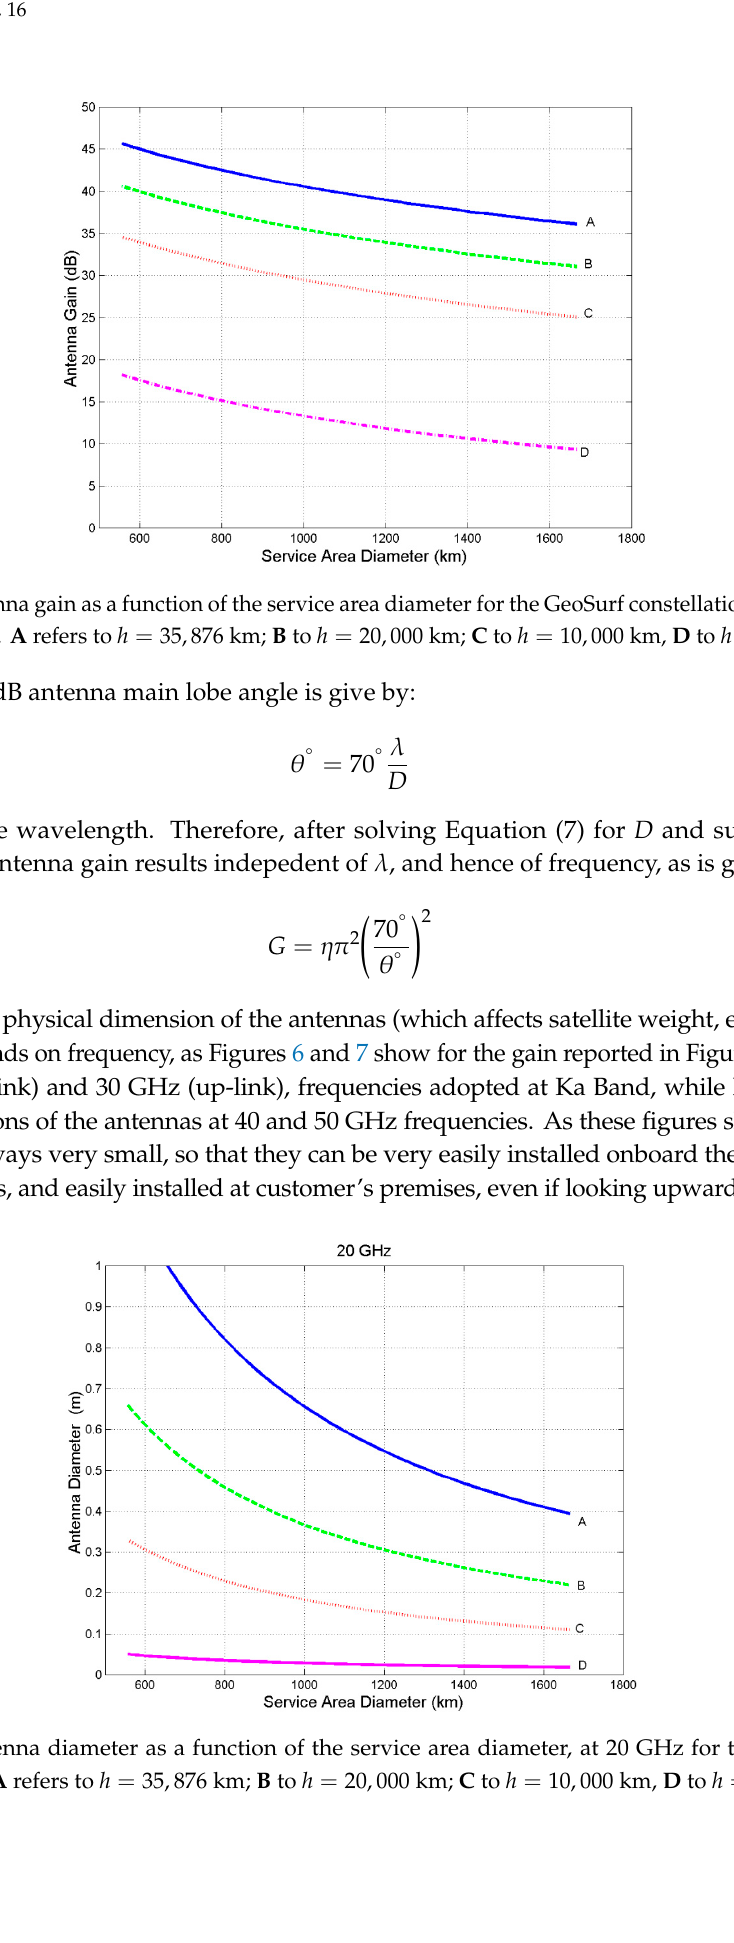
Figure 7. Antenna diameter as a function of the service area diameter, at 30 GHz for the GeoSurf constellation. A refers to h = 35,876 km; B to h = 20,000 km; C to h = 10,000 km, D to h = 1500 km.